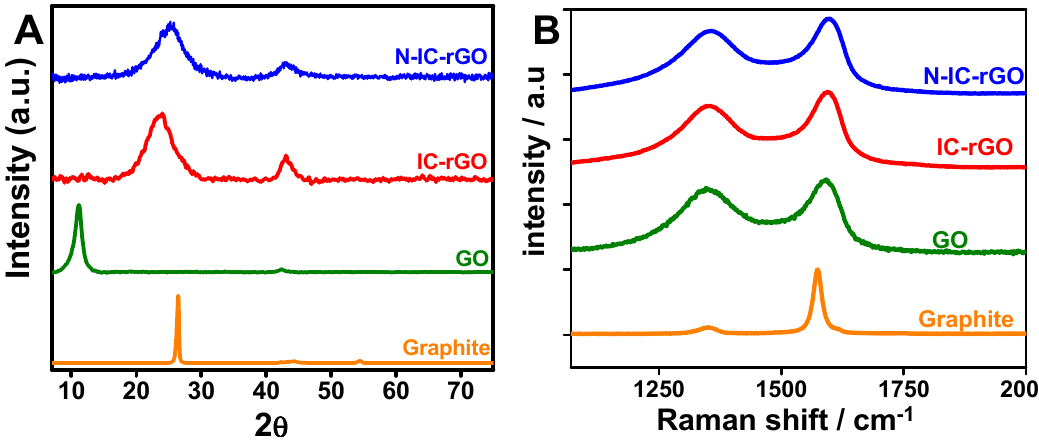
Figure 2. ( A ) X-ray diffraction (XRD) patterns of graphite, graphene oxide (GO), IC-rGO and N-IC-rGO; ( B ) Raman spectrum of graphite, GO, IC-rGO, and N-IC-rGO (Adapted from ref. [78,81], with permission from Royal Society of Chemistry and Elsevier, 2017 and 2020).